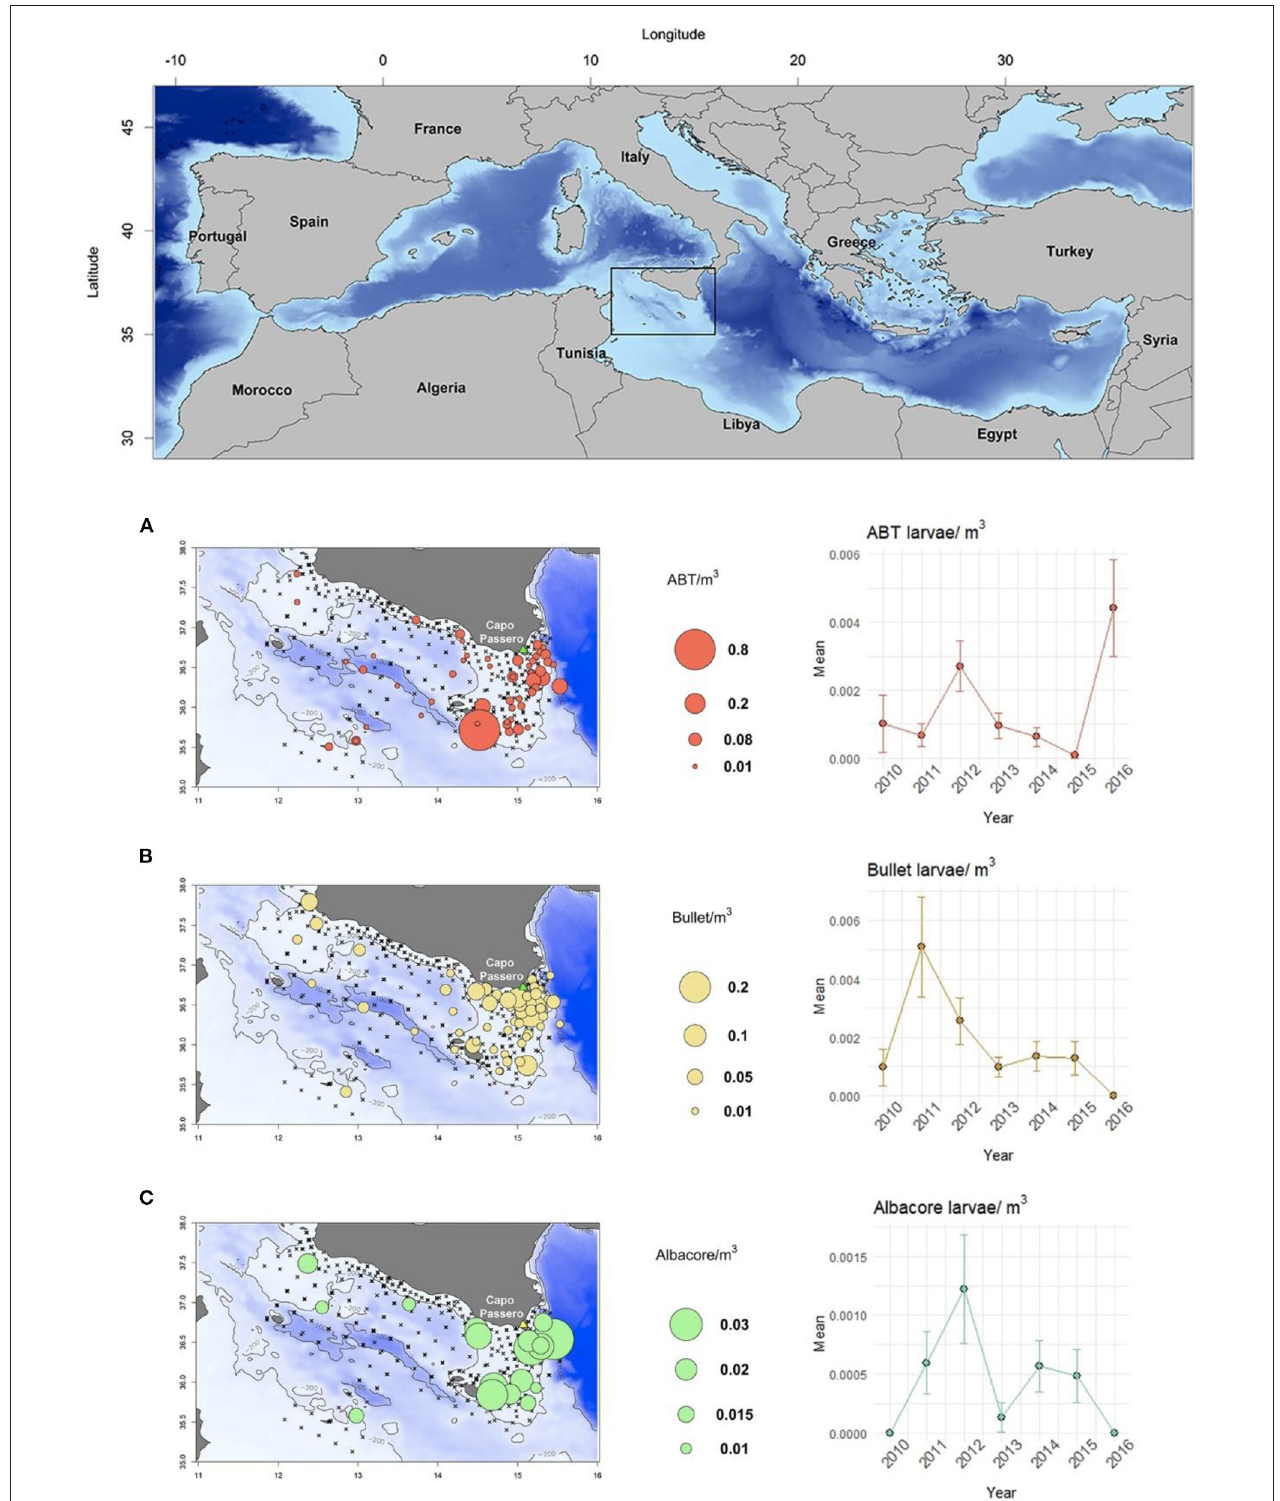
FIGURE 1 | Study area and geographical distribution of (A) Atlantic bluefin tuna (ABT), (B) bullet tuna, and (C) albacore tuna, and interannual changes in nominal larval densities in sites repeated annually.